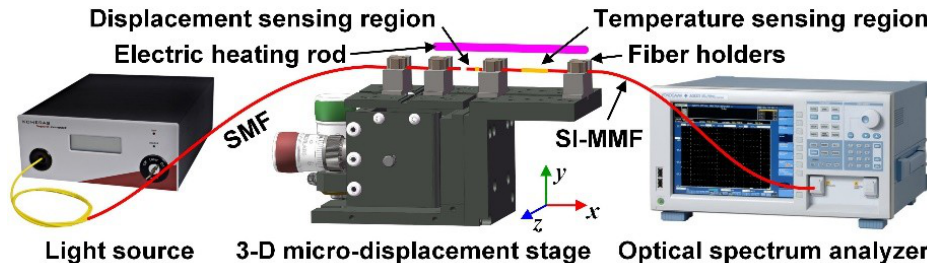
Figure 6. ( a ) Three-dimensional testing result for the gold coating with a groove; ( b ) test result for the groove depth, which is equal to the gold coating thickness.